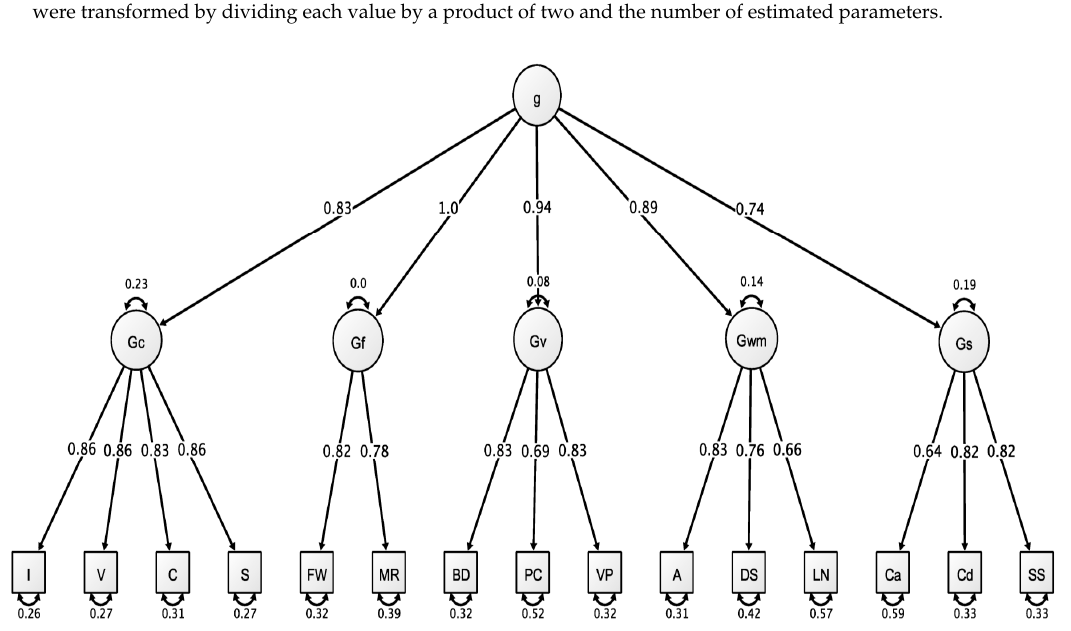
Figure 2. Hungarian Wechsler Adult Intelligence Scale Fourth Edition data applied to the Higher-Order model of intelligence. All values are standardized from the confirmatory factor analysis conducted using lavaan. Figure generated using Ω nyx.